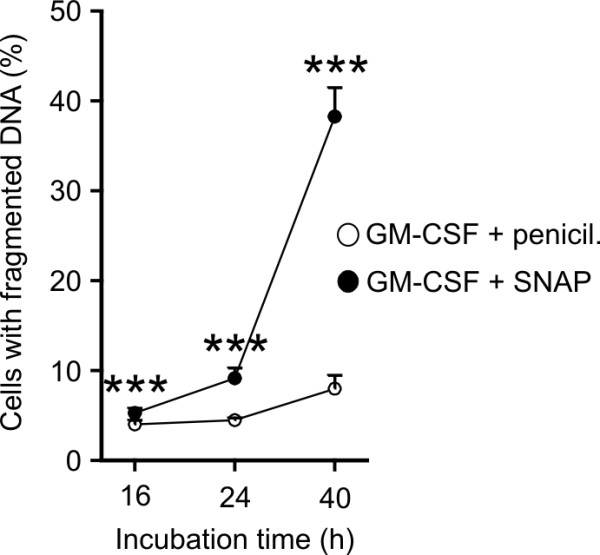
SNAP induces late apoptosis in GM-CSF-treated eosinophils. Eosinophils were incubated in the presence or absence of 1 mM SNAP, 1 mM penicillamine and/or 10 pM GM-CSF for the indicated times. Apoptosis was measured by DNA fragmentation assay. *** indicates p < 0.001 as compared with cells treated with GM-CSF and penicillamine at the corresponding time-point. Mean ± SEM is shown from six independent experiments.